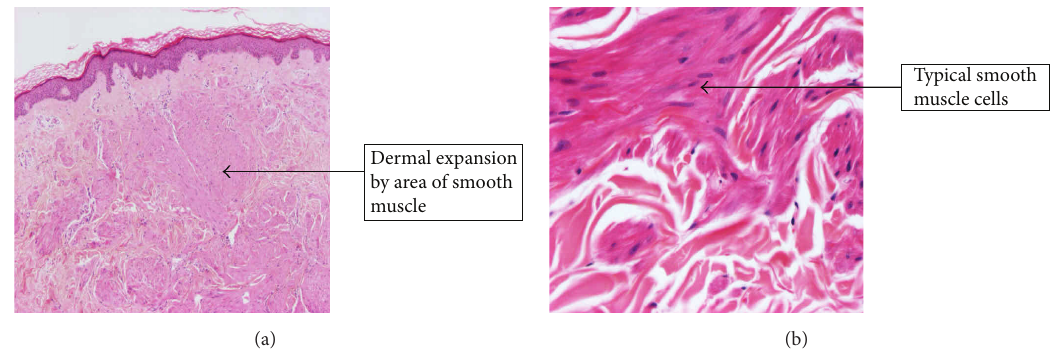
Figure 2: (a) H&E stained section shows an ill-defined proliferation of smooth muscle in the upper to mid dermis; (b) higher power of typical smooth muscle cells of the lesion without atypia or pleomorphism; (a) × 4; (b) ×